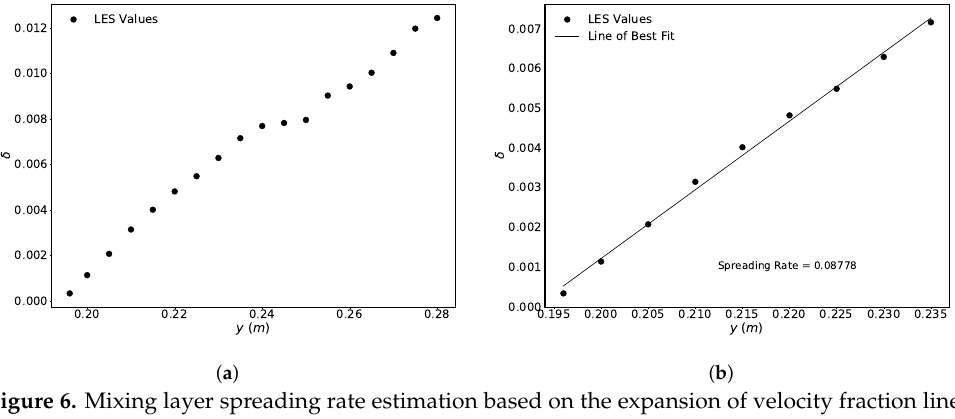
Figure 6. Mixing layer spreading rate estimation based on the expansion of velocity fraction lines plotted over a streamwise distance covering the initial linear region and well into the region where three-dimensional effects are expected to become significant as the axisymmetric shear layer transi- tions into an axisymmetric jet. In ( b ), a line of best fit is inserted through the strongly linear initial mixing layer phase up to approximately Y / D orifice ≈ 5, yielding the spreading rate SR δ = 0.0878. ( a ) Points up to Y / D orifice ≈ 9. ( b ) Points up to Y / D orifice ≈